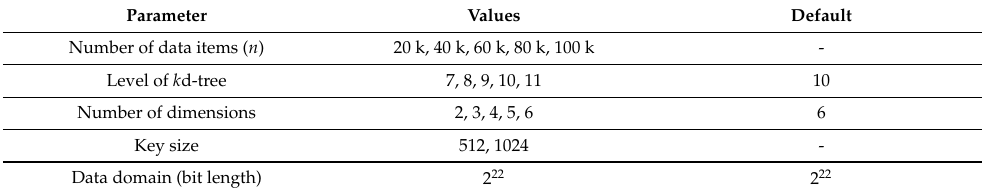
Table 2. Parameters for performance evaluation in a multi-core